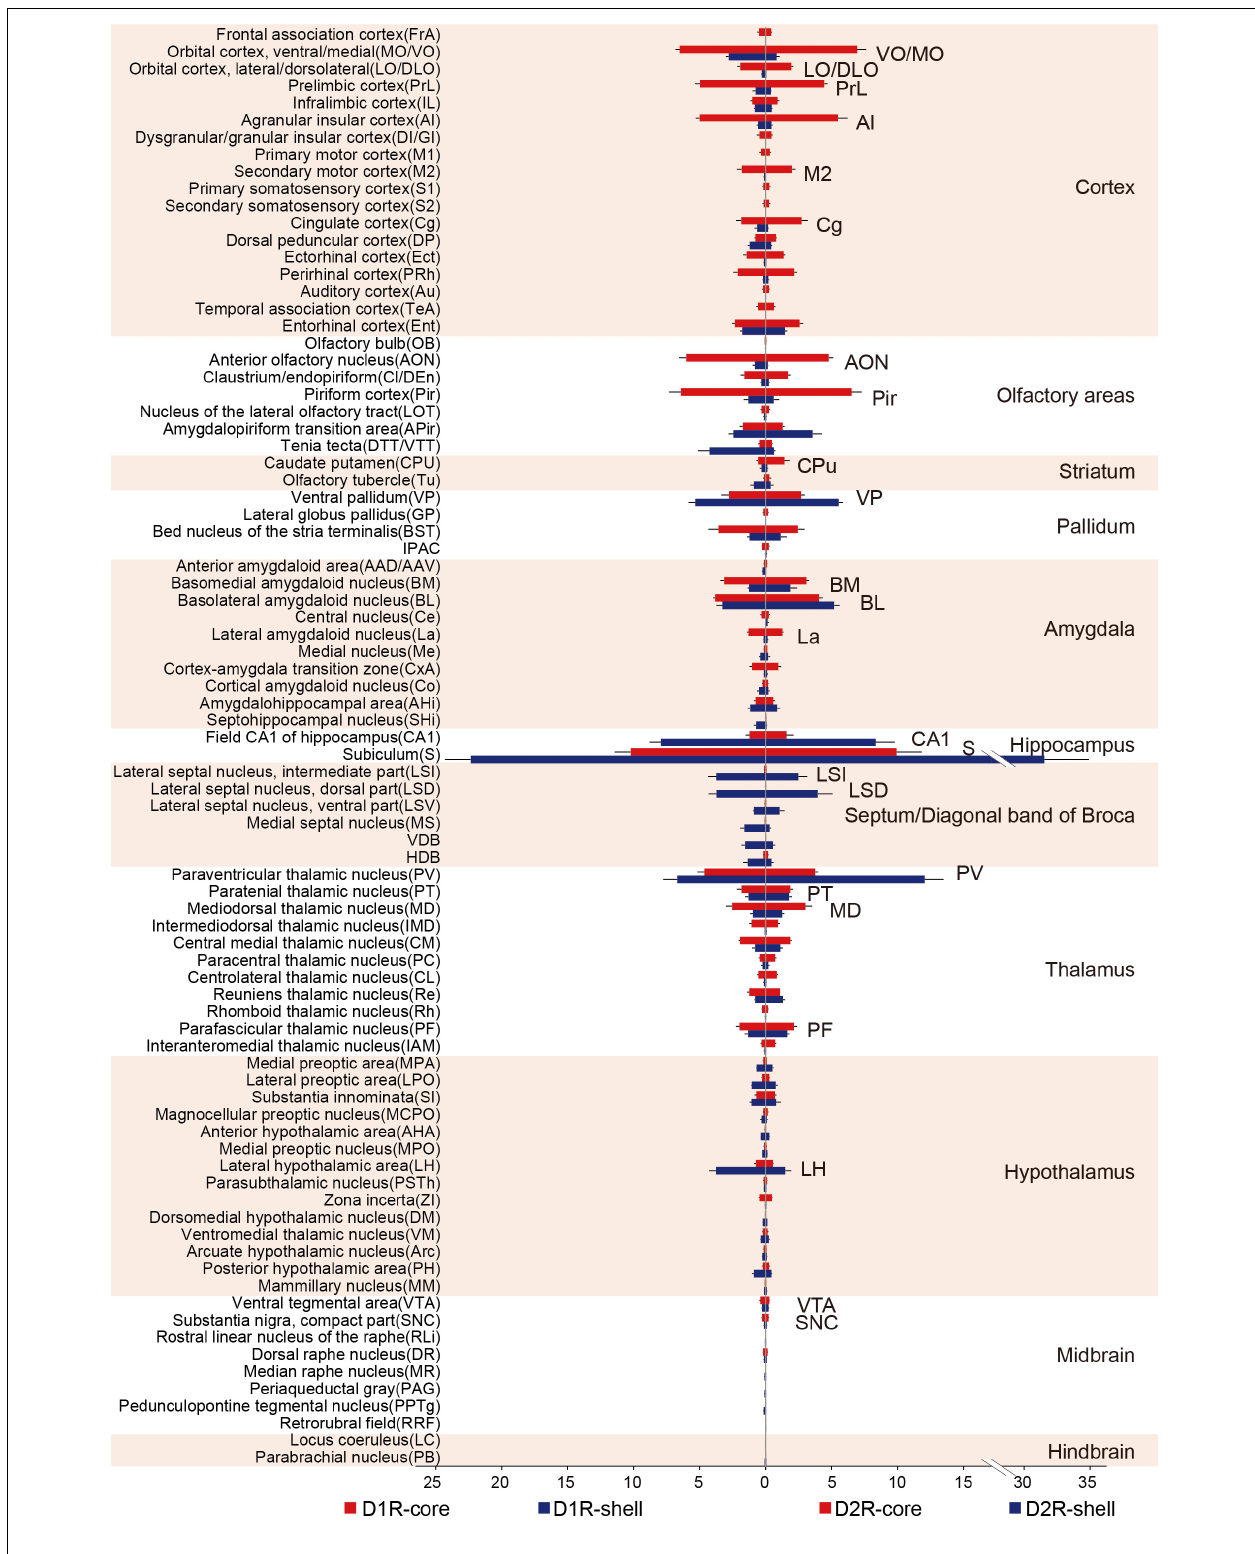
FIGURE 4 | Quantitative analysis of the proportions of whole-brain input to D1R-MSNs and D2R-MSNs in different NAc subregions. (Left) Monosynaptic inputs to D1R-MSNs in the NAc core (red) and NAc shell (blue). (Right) Monosynaptic inputs to D2R-MSNs in the NAc core (red) and NAc shell (blue). Mean ± SEM ( n = 6 mice for each